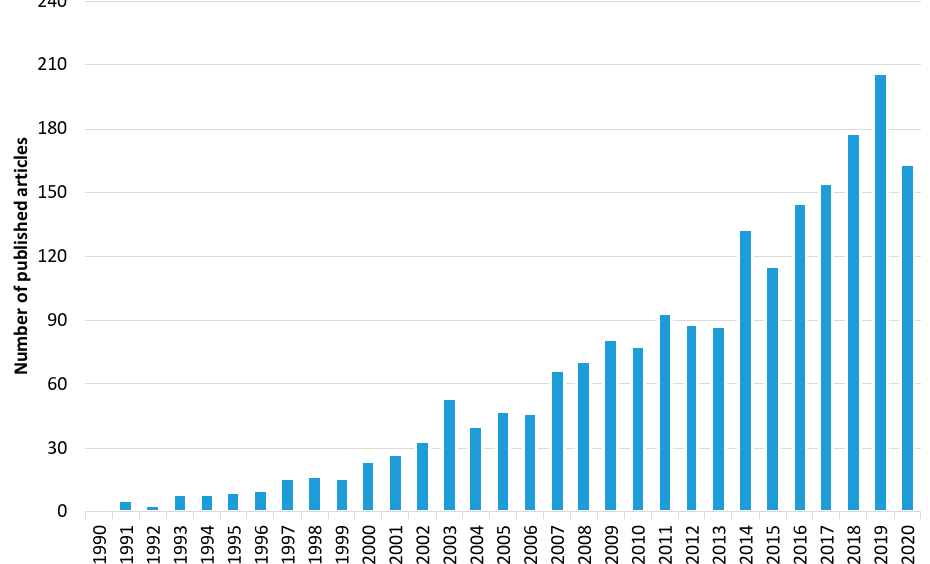
Figure 5. The number of published articles per year related to forest fire detection. Data retrieved from Web of Science [134] for dates between 1990 to October 2020.